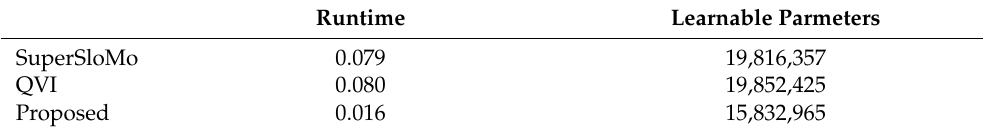
Table 2. Comparison of runtime and number of learnable parameters with the proposed method.